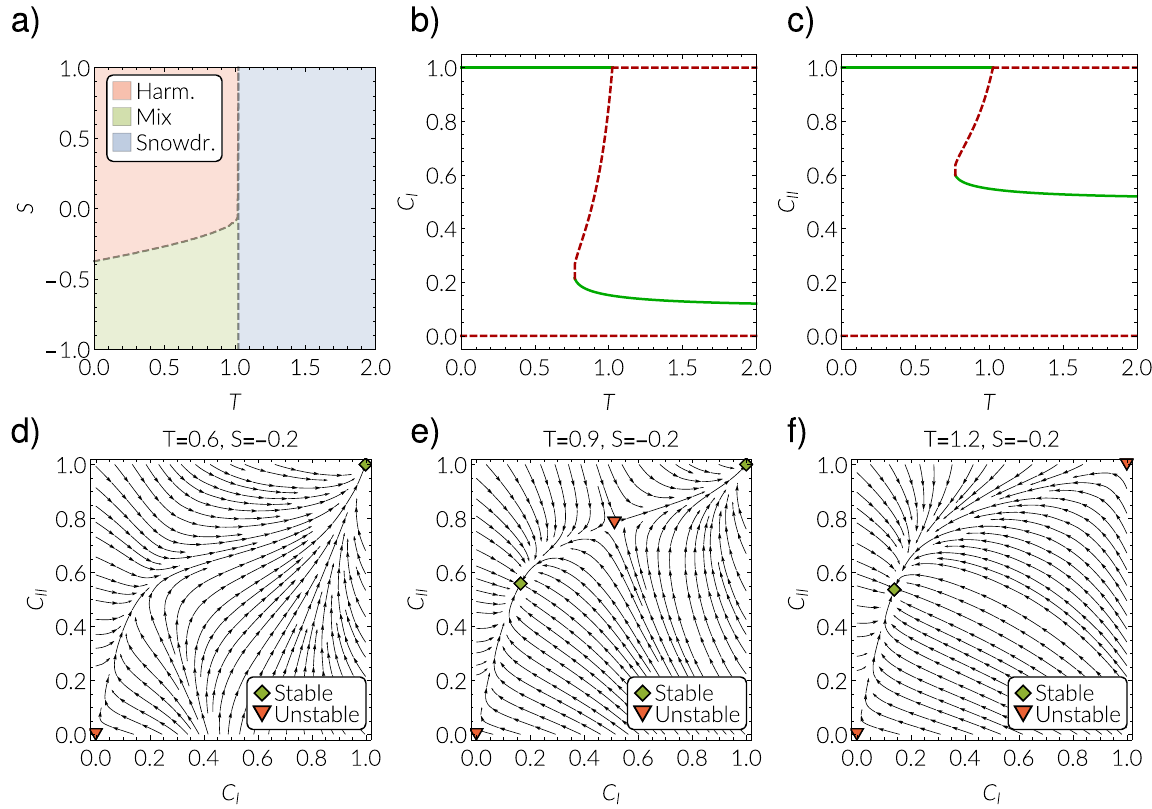
Figure 2. Behavior of the system for γ = 0.2 and β = 0.7 and 〈 k 〉 = 6. ( a ) Shows the phase diagram. In the red area, full cooperation is the only stable solution and we effectively observe the behavior known from the harmony game. In the opinion layer, “cooperate” is the only prevailing opinion. This behavior is illustrated in the stream plot shown in ( d ) for T = 0.6 and S = − 0.2. In the blue area in ( a ), the only stable solution is a mixed state with 0 < C I < 1 and 0 < C II < 1, and in general we have C I ≠ C II . This region corresponds to T > T c ,2 ≈ 1.03. ( f ) shows this behavior as a stream plot for T = 1.2 and S = − 0.2. In the green area in ( a ), we have a bistable behavior, where either full cooperation is approached in both layers, but the mixed state is stable as well. ( e ) shows this behavior as a stream plot for T = 0.9 and S = − 0.2. In the bifurcation diagrams in ( b ) and ( c ) this region corresponds to T c ,1 < T < T c ,2 , where T c ,1 ≈ 0.77. Green solid lines represent stable fixed points and dashed red lines unstable fixed